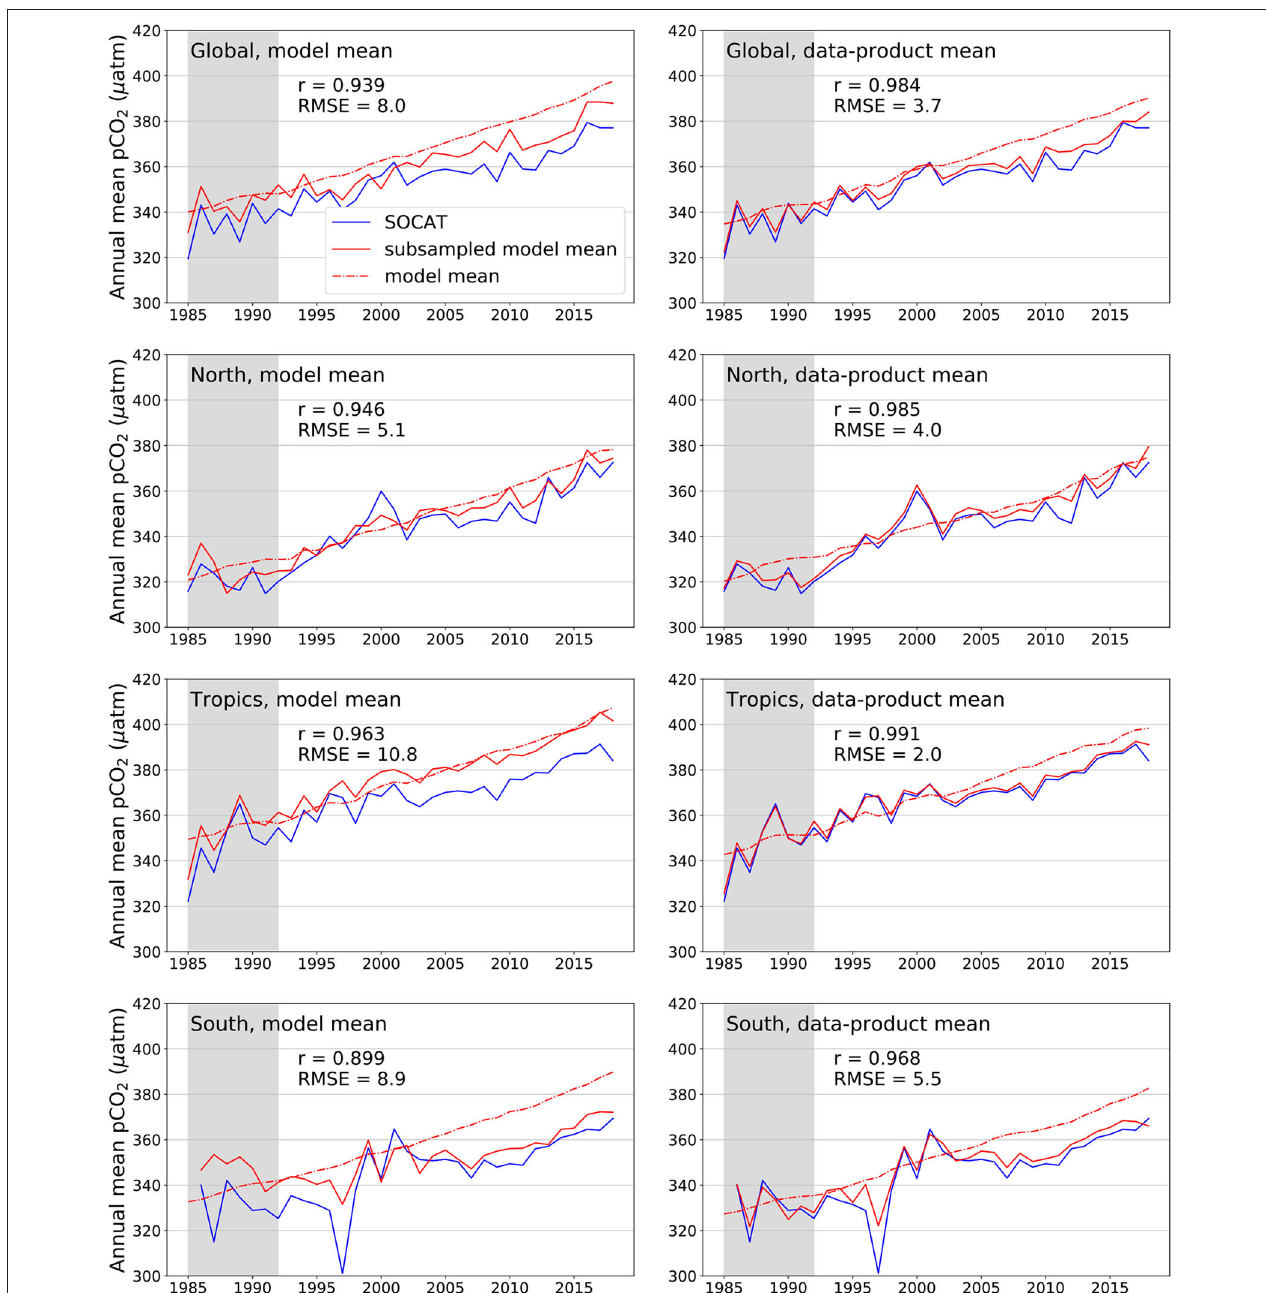
FIGURE 8 | Comparison between annual sea-surface p CO 2 from SOCATv2019 (Bakker et al., 2016) and the model ensemble mean (left) or data-product ensemble mean (right) globally (top), and in the different regions North, Tropics, South as indicated in the figures. Red solid line shows model or data-product mean from subsampled models/data-products at SOCAT sampling sites. Broken lines indicate the area-weighted average from the full models (not subsampled). Correlation coefficient r and Root Mean Squared Error RMSE are calculated from the annual time-series 1992–2018, i.e., the white area in the figures. These figures are shown for all models and data-products separately in the Supplementary Material